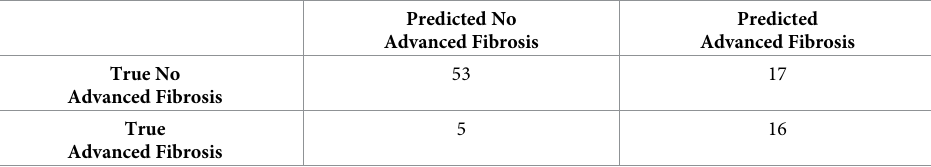
Table 2. Confusion matrix for the ability of kph to identify patients with advanced